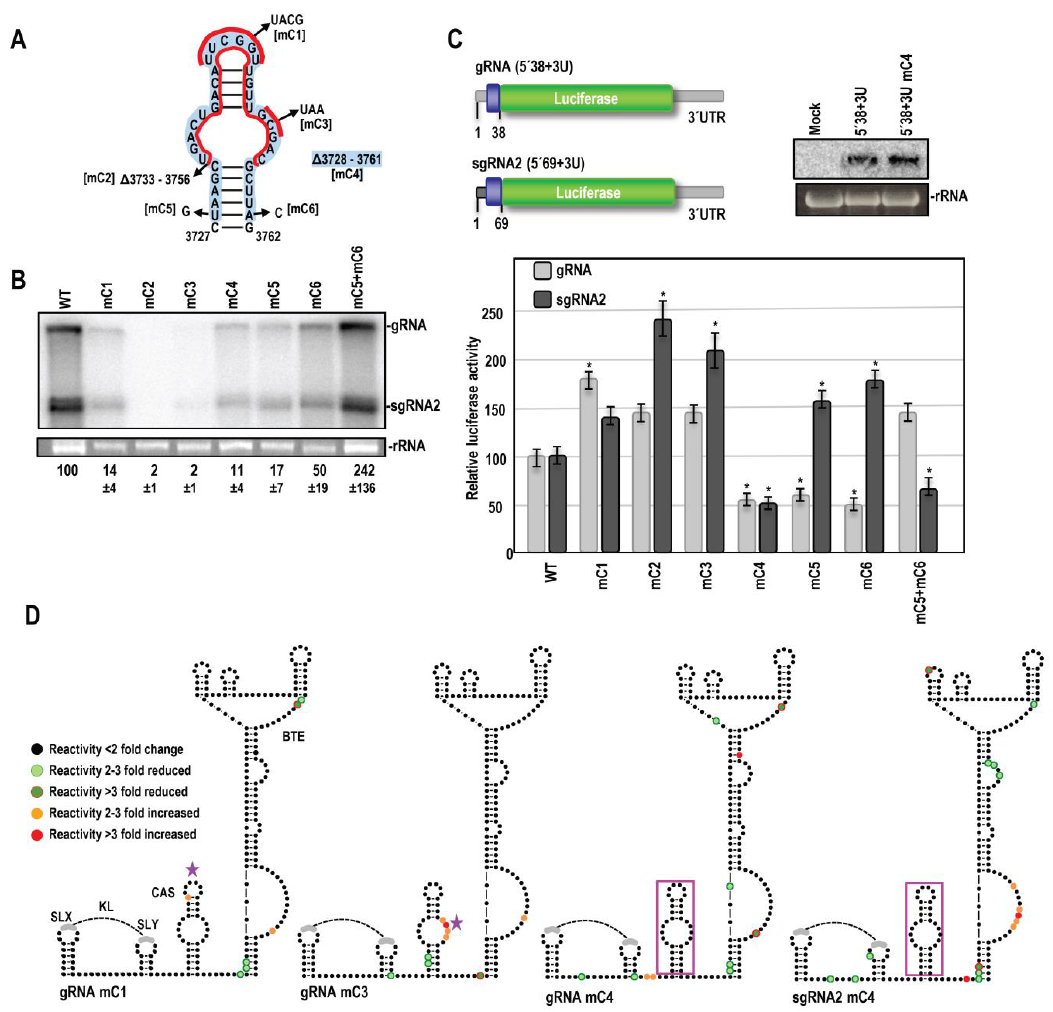
Figure 5. CAS is important for OPMV accumulation in N. benthamiana and efficient translation of reporter constructs. ( A ). CAS nucleotide alterations and deletions. Names of mutations are in brackets. Red lines help define some of the mutations and deletions. Blue shading denotes residues deleted in mC4. ( B ). RNA gel blot analysis of total RNA extracted from systemically infected N. benthamiana following agroinfiltration with either WT or mutant OPMV. Ethidium bromide-stained 26S rRNA was used as the loading control, with which band intensities were normalized. Standard error is shown for three independent experiments. ( C ). Relative translation of OPMV gRNA and sgRNA reporter transcripts containing full- length 3ʹUTR and 5ʹ terminal sequences [non -coding (gray) and coding (blue)] necessary for efficient translation as previously described [20]. gRNA construct; 5 ʹ terminal 38 nt (5ʹ38 + U). sgRNA2 construct; 5ʹ terminal 69 nt (5ʹ69 + U). Luciferase activity was assayed 18 h following protoplast transfection. Error bars denote standard deviation for three independent assays. ‘*’ Denotes statistical difference with p < 0.05 analyzed using the t -test. Right panel shows approximately equal accumulation of gRNA parental and mC4 luciferase transcripts at the 18 h time point as assayed by RNA gel blots, indicating that the deletion was not affecting the stability of the transcripts. Ethidium bromide-stained 26S rRNA was used as a loading control. ( D ). SHAPE RNA structure probing of selected OPMV gRNA and sgRNA full-length CAS mutant transcripts. Colors denote changes in mutant nucleotide reactivity relative to WT. Black dots, <2-fold change; light green, 2- to 3-fold reduction; dark green; >3-fold reduction; orange, 2- to 3-fold increase; red, >3-fold increase. Star denotes location of alterations. CAS deletion is boxed in magenta. SHAPE data were averaged from at least three independent